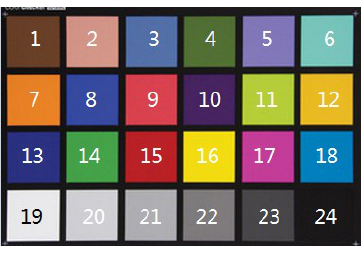
Figure 5. Munsell color checker.